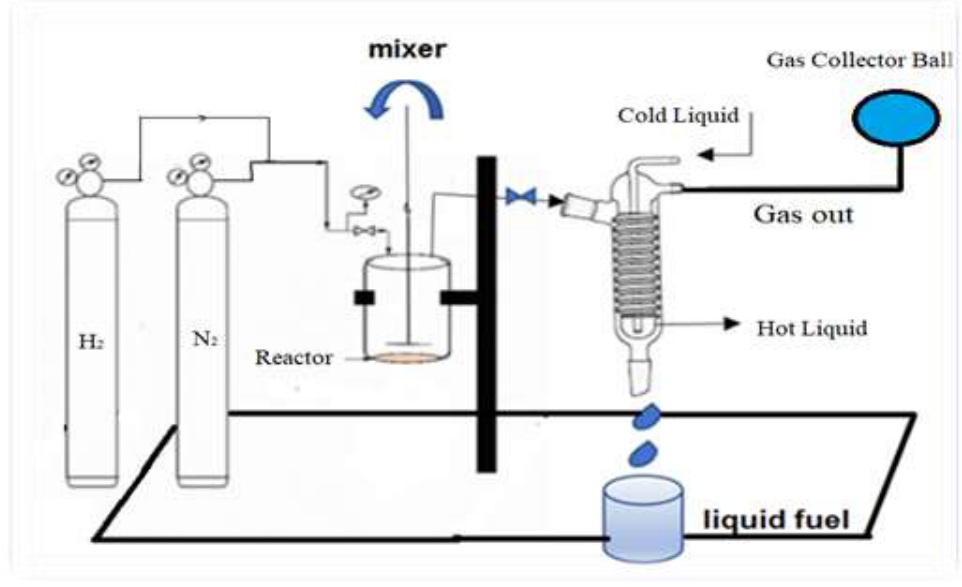
Figure 1: A sketch of the experimental system.